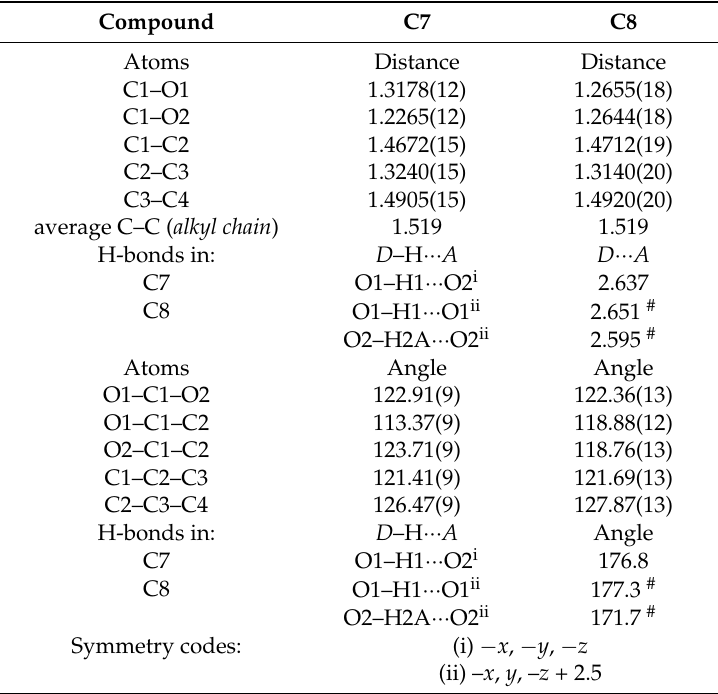
Table 2. Selected atom distances (Å) and angles ( ˝ ) for C7 and C8